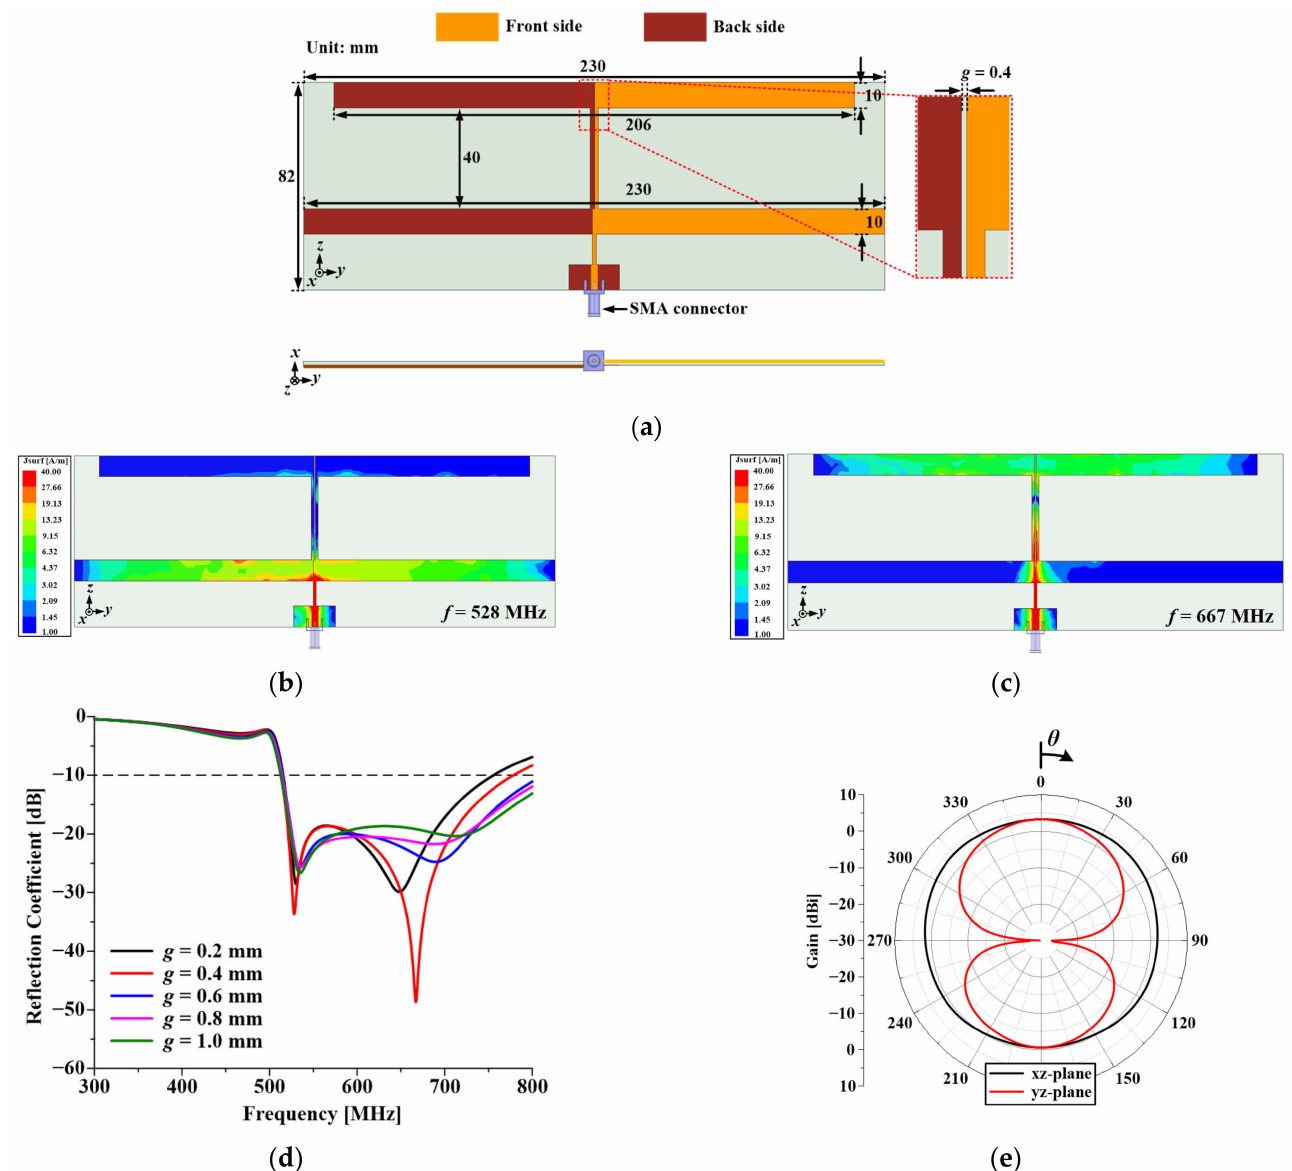
Figure 7. Single dipole antenna: ( a ) geometry of antenna, ( b ) simulated surface current density at 528 MHz, ( c ) simulated surface current density at 667 MHz, ( d ) simulated reflection coefficient performances for various g values, and ( e ) simulated radiation patterns at 580 MHz ( g = 0.4